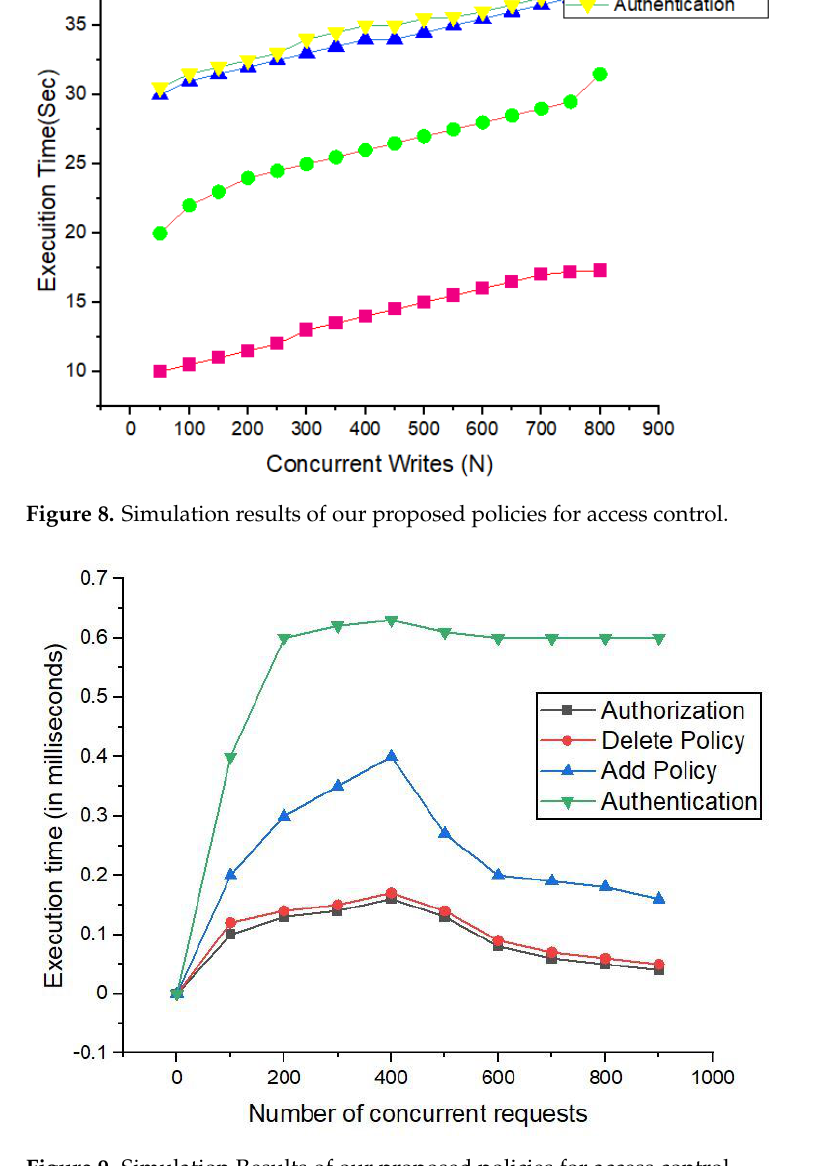
Figure 9. Simulation Results of our proposed policies for access